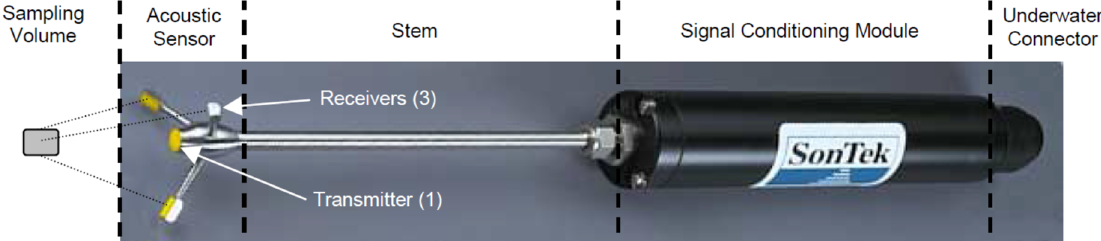
Figure 3. Three-dimensional Sontek Micro acoustic Doppler velocimeter (ADV) 16 megaHertz (MHz). Table 2. Technical characteristics of the 3D Sontek Micro acoustic Doppler velocimeter (ADV) 16 MHz.